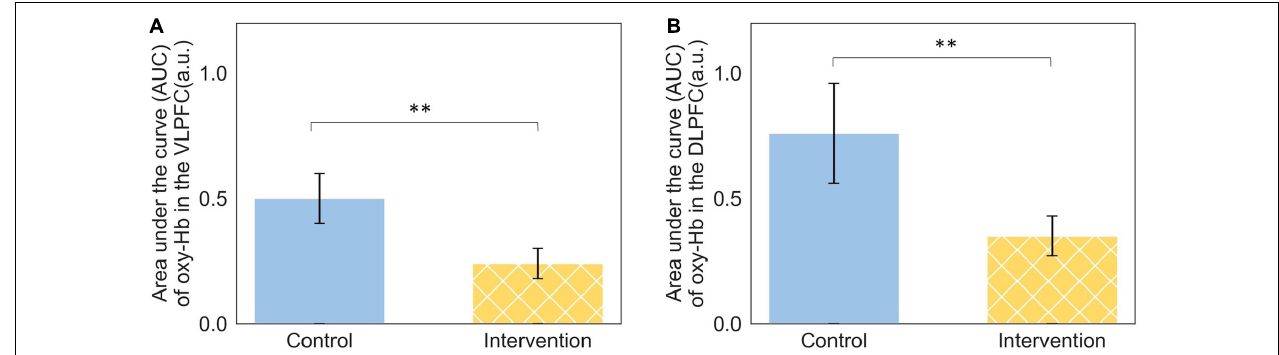
FIGURE 4 | (A) Neuro-cognitive activation in the right VLPFC when evaluating the perceived environmental benefits of green infrastructure represented as the area under the curve and (B) neuro-cognitive activation in the left DLPFC when evaluating the perceived community benefits of green infrastructure represented as the area under the curve, ∗∗ p <